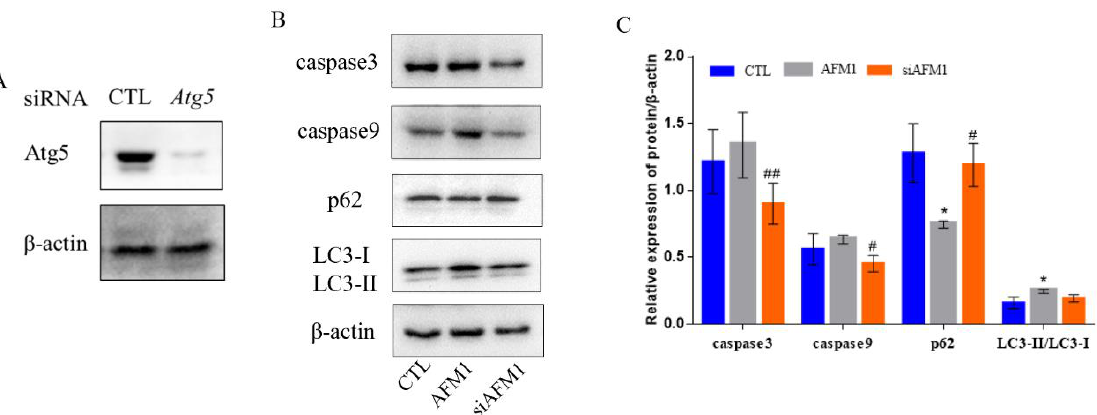
Figure 4. The apoptosis and autophagy of NCM460 cells transfected with siRNA-Atg5. ( A ) Transfection effect of siRNA-Atg5 in NCM460 cells. ( B , C ) Relative expression of apoptosis and autophagy proteins with or without transfected NCM460 cells after treatment with AFM1 for 12 h. Results represented as means ± SD. * p < 0.05 vs. control (CTL). # p < 0.05, ## p < 0.01 vs. AFM1.